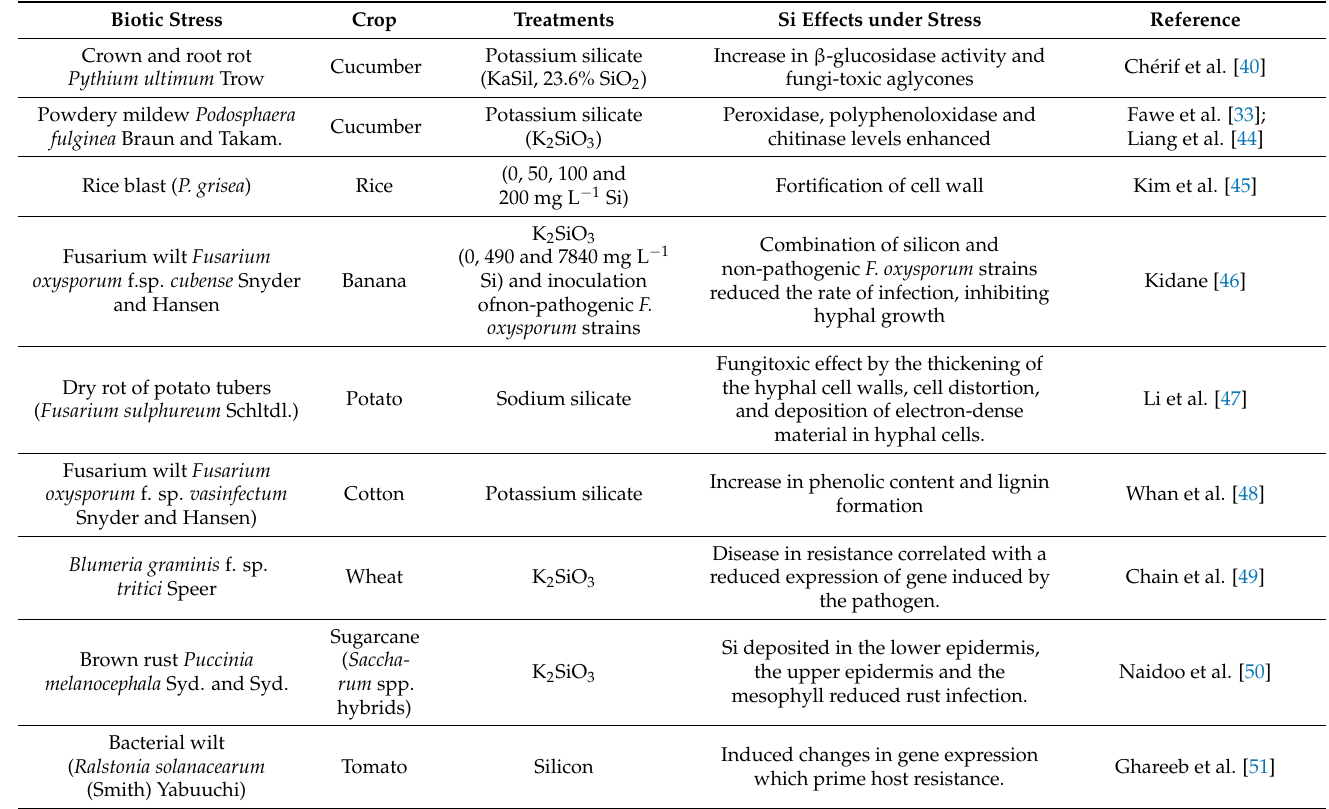
Table 2. Si uptake in plants and its mechanism in alleviating biotic